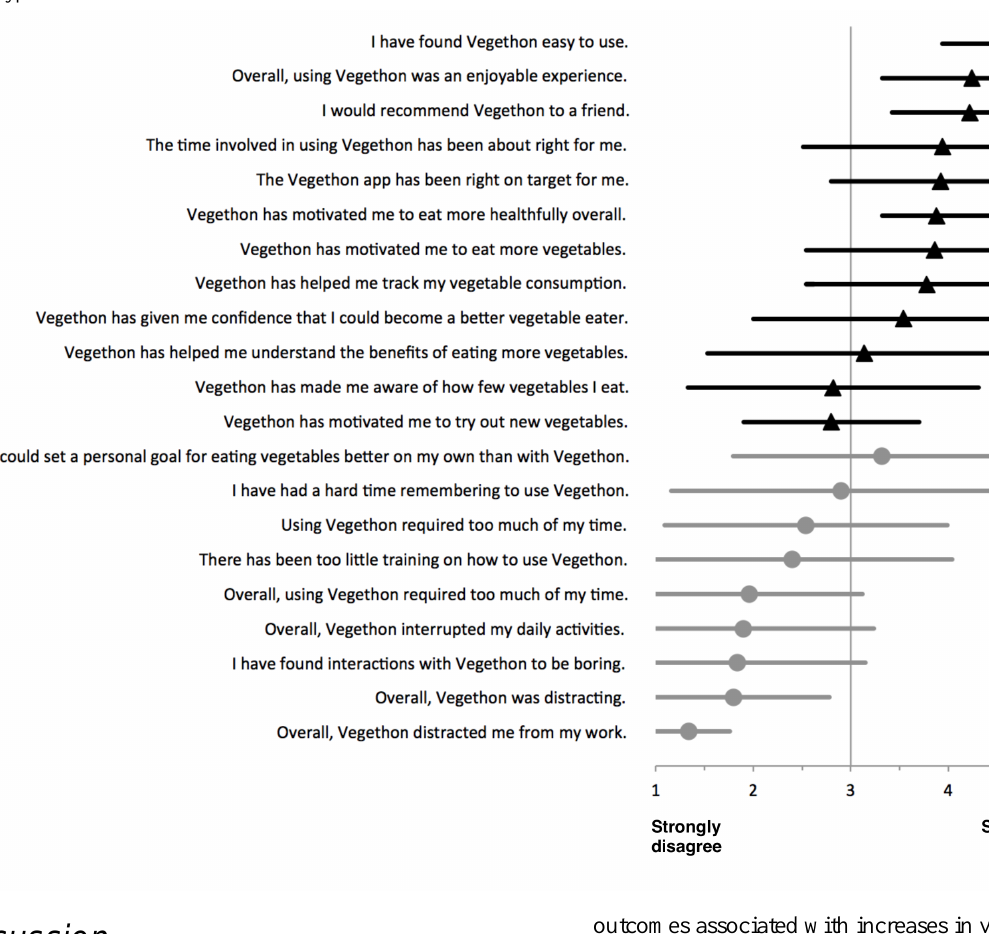
Figure 6. Satisfaction with and usability of mobile app intervention. Mean (triangles and circles) and SD (horizontal lines). This exploratory analysis excludes 2 participants who were lost to follow-up and 1 participant who did not use the app. Participants were asked to rate each statement on a 5-point Likert-type